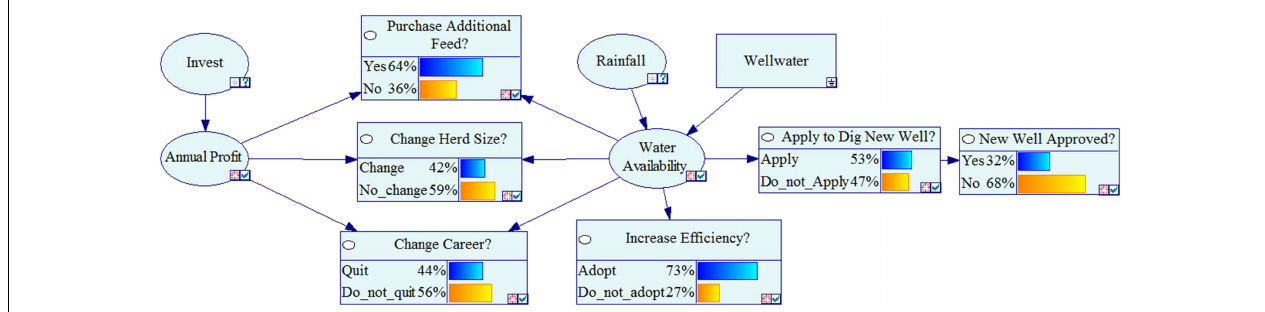
FIGURE 2 | Bayesian cognitive map of important decisions when an individual rancher’s annual profit is unknown, his well is dry, and potential rainfall is under normal conditions (Pope and Gimblett, in